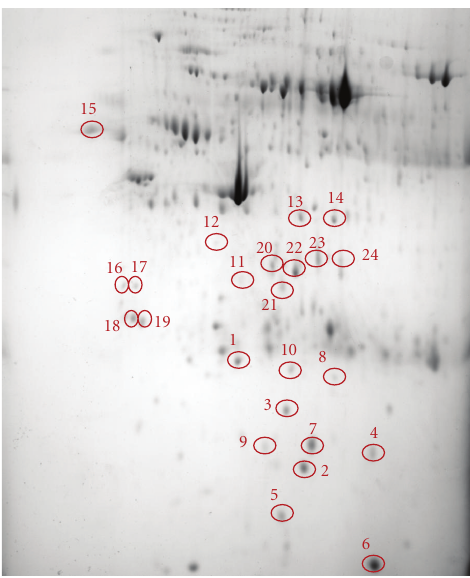
Figure 2: Protein spots selected for in-gel